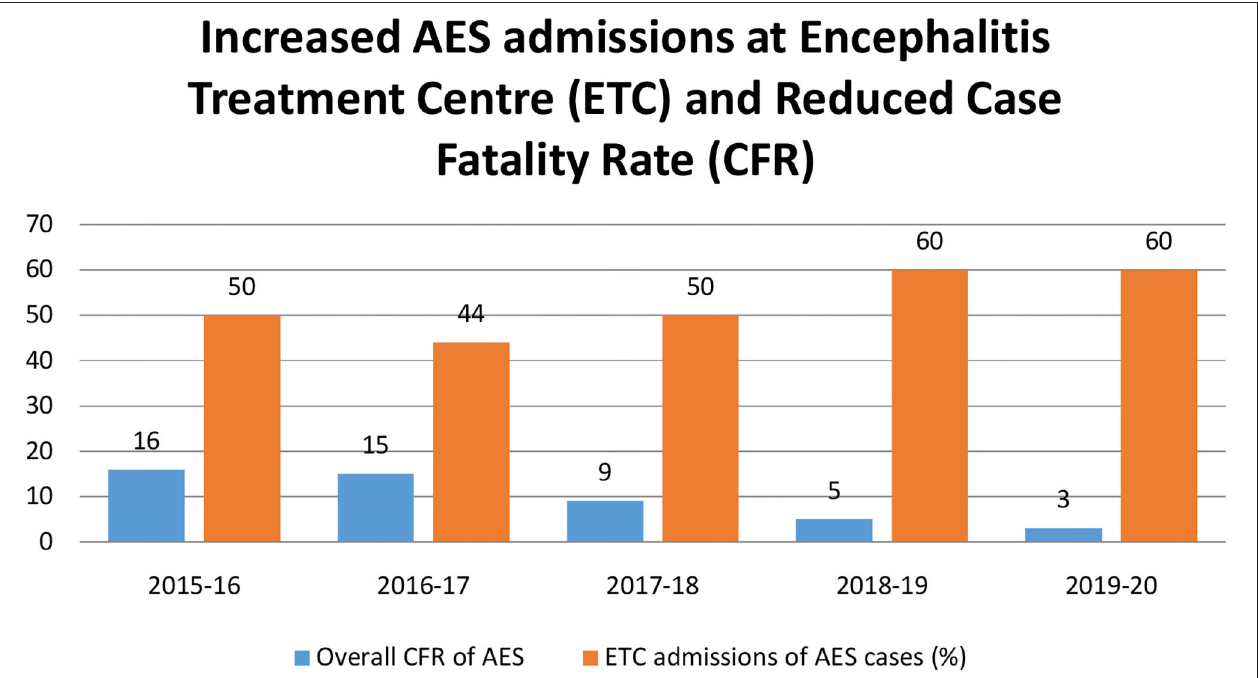
FIGURE 5 | Graphical representation of increased AES admissions at Encephalitis Treatment Centre (ETC) constructed at peripheral health centers in UP and reduced CFR due to AES in UP during 2015 and